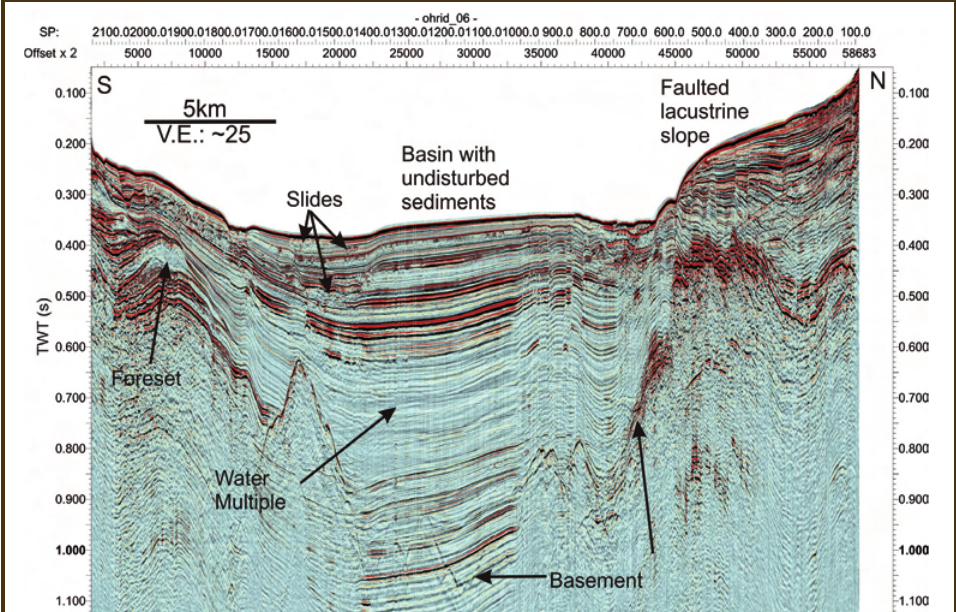
Figure 3. Brute stack of a multichannel air-gun seismic profile collected in 2007 (Krastel et al., unpublished data). The central part of the profile indicates a >700-m-thick succession of undisturbed